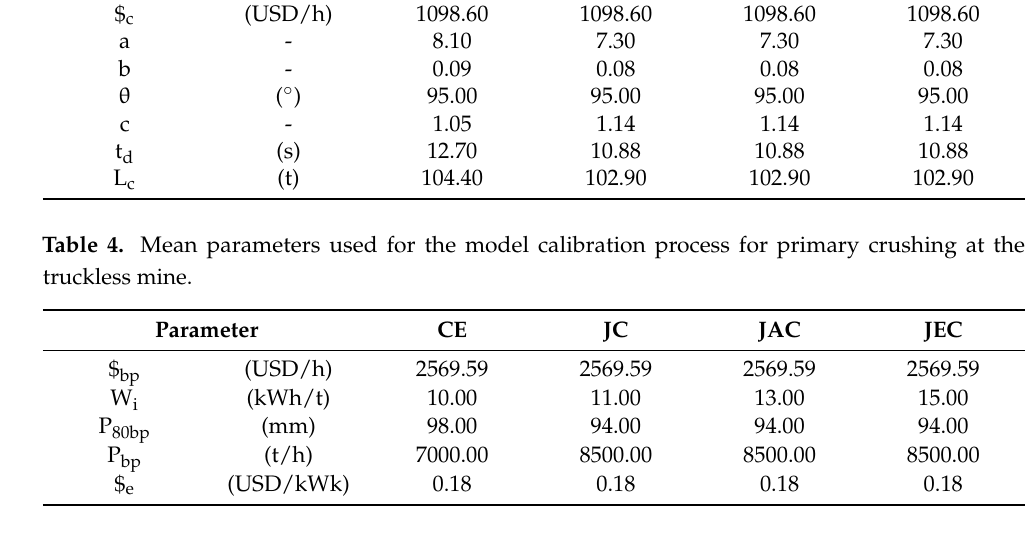
Table 3. Mean parameters used for the model calibration process for loading at the truckless mine. Parameter CE JC